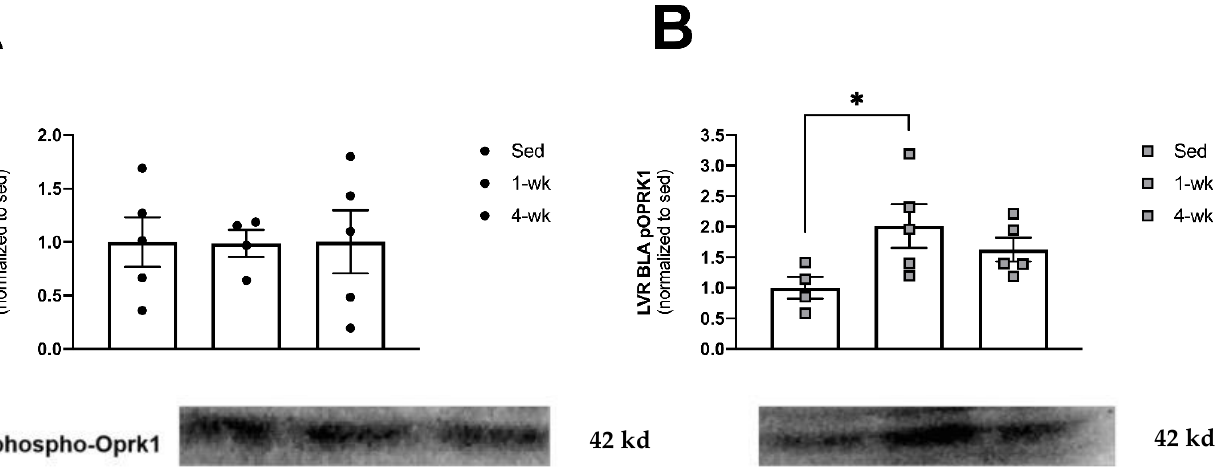
Figure 4. Comparison of sedentary versus 1 or 4 weeks of wheel-running on BLA phospo-Oprk1 protein expression in ( A ) WT (n = 5/group; closed circles) and ( B ) LVR (n = 5/group; gray squares). * post-hoc difference relative to sedentary group ( p < 0.05). Values shown as mean ± SE.